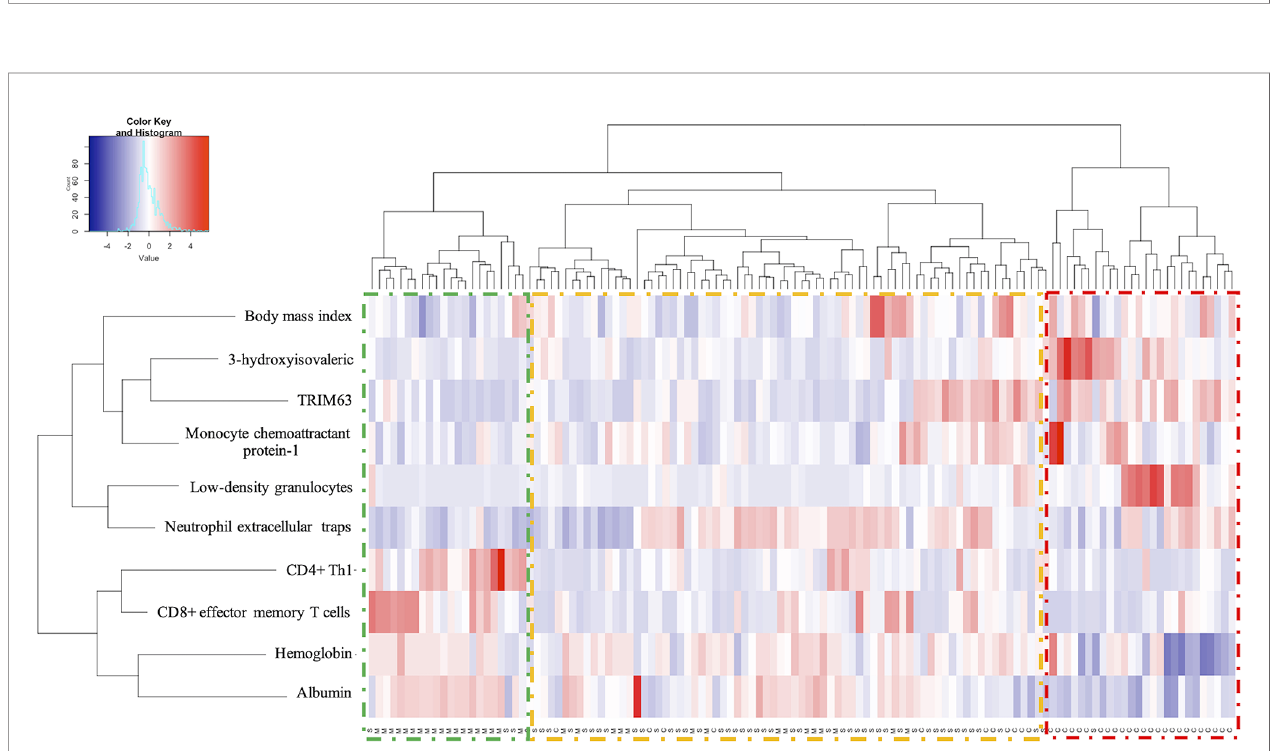
FIGURE 1 | Prediction probabilities of COVID-19 severity for the variables included in the model. The graphs represent the size of the effect of each explanatory variable in the disease severity.